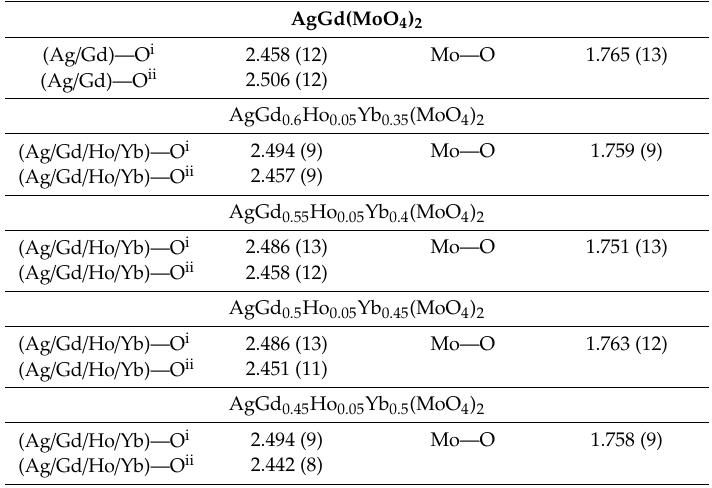
Table 3. Main bond lengths (Å) of AgGd 1 − x − y Ho x Yb y (MoO 4 ) 2 samples.